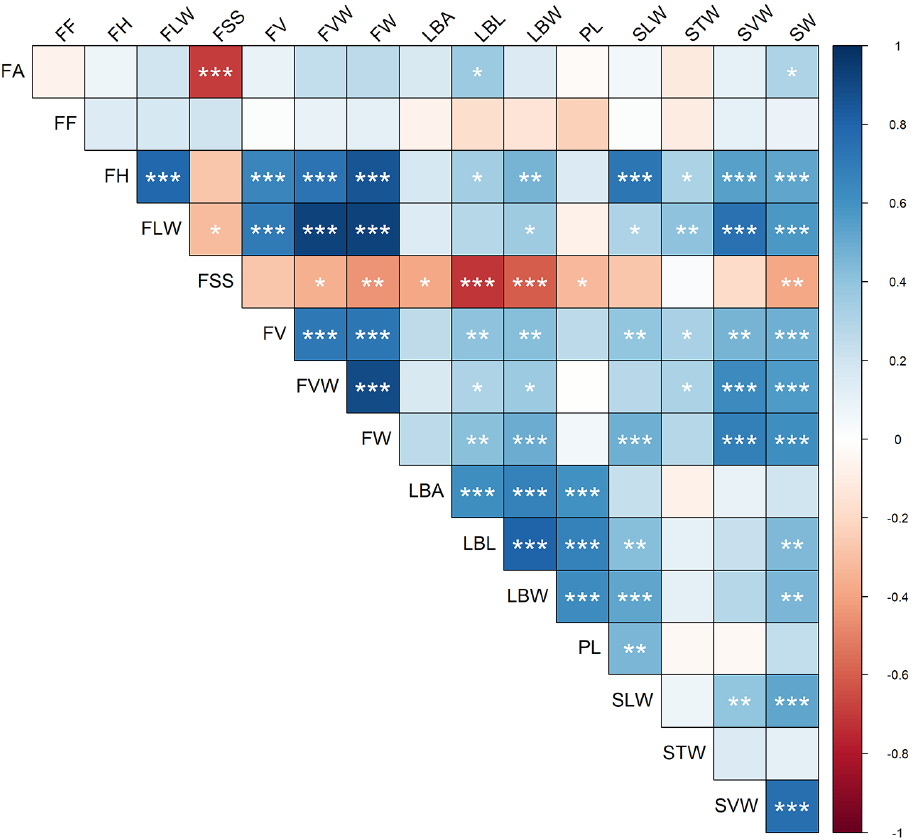
Figure 4. Correlogram (Pearson) of the 16 quantitative traits. Pairwise correlations between variables are color-mapped according to the scale bar on the right-hand side. Asterisks indicate statistically significant correlations (*: p < 0.05; **: p < 0.01; ***: p < 0.001). Trait codes are reported in Table